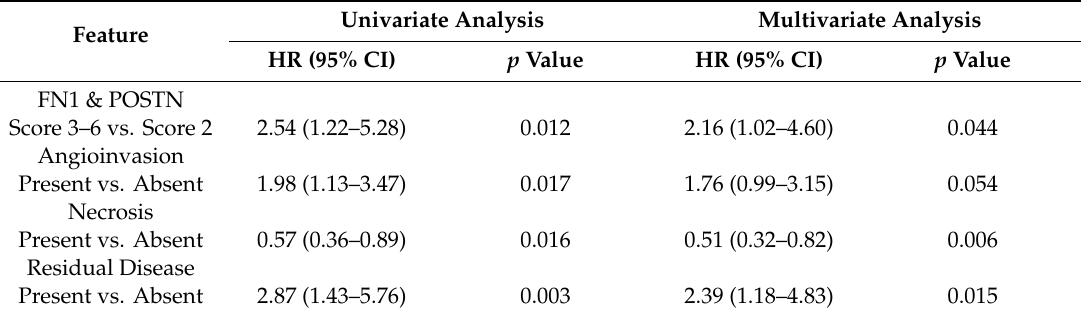
Table 3. Univariate and multivariate analysis of overall survival.